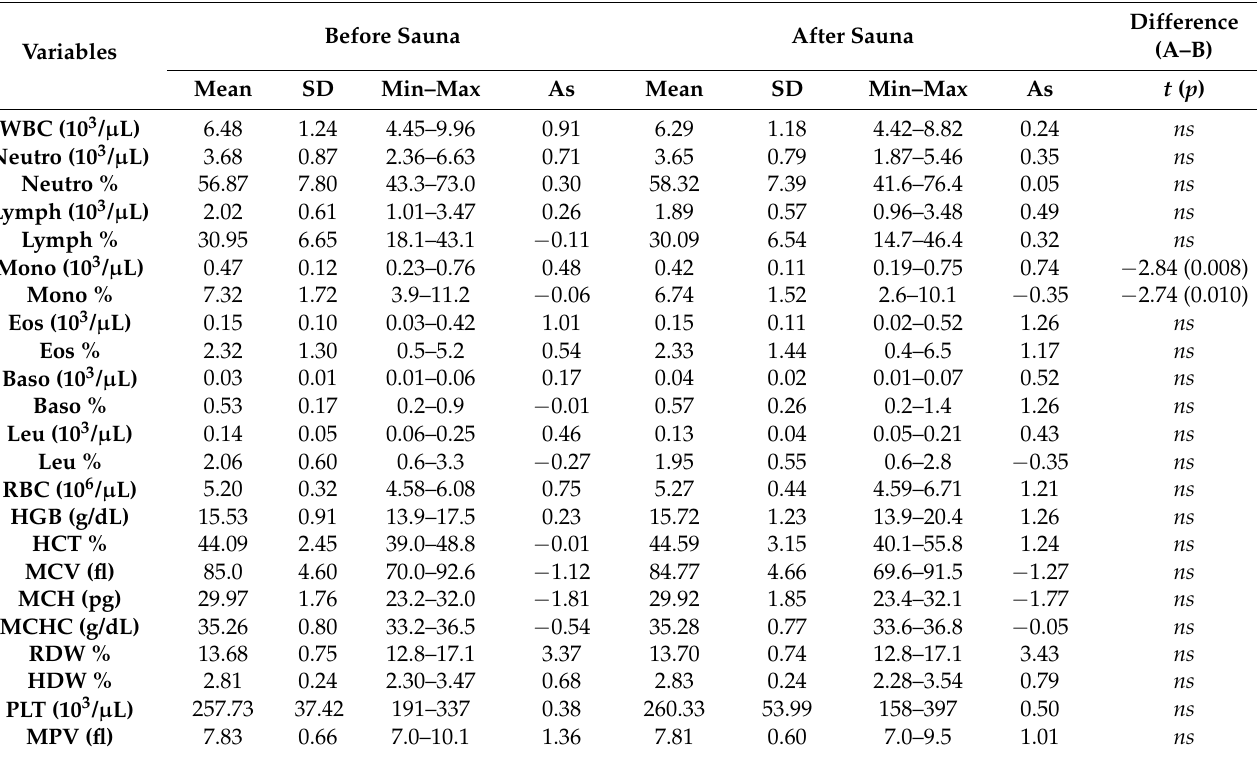
Table 3. Descriptive statistics of blood parameters before and after sauna